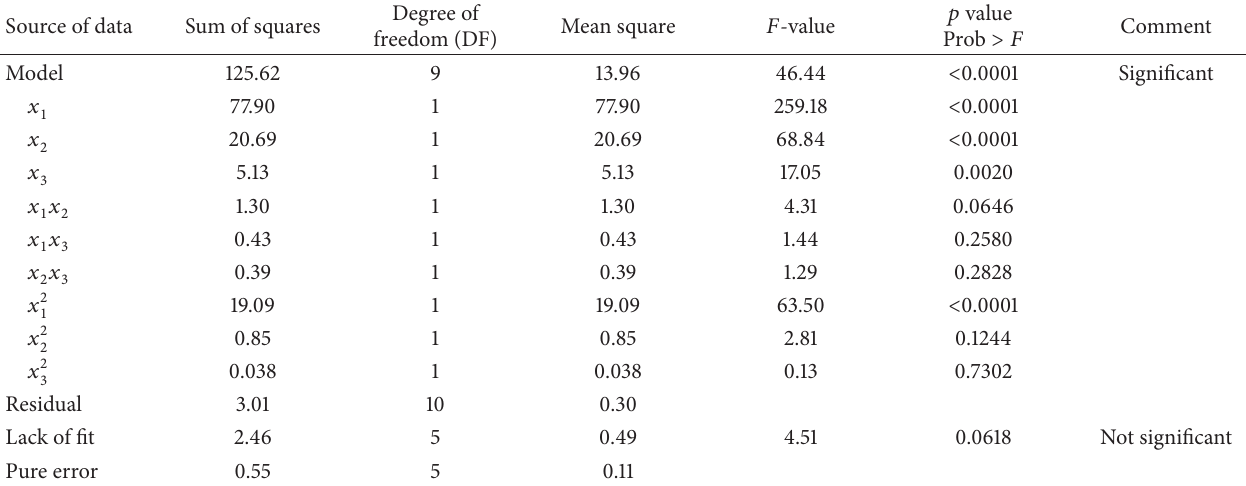
Table 3: Analysis of variance (ANOVA) for response surface quadratic model for